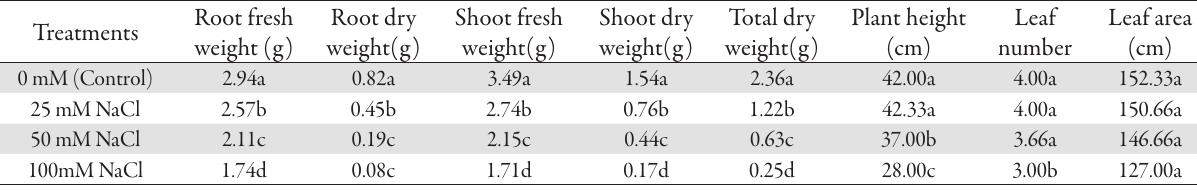
Tab. 2. Means comparison of soybean growth parameters affected by salt stress Treatments